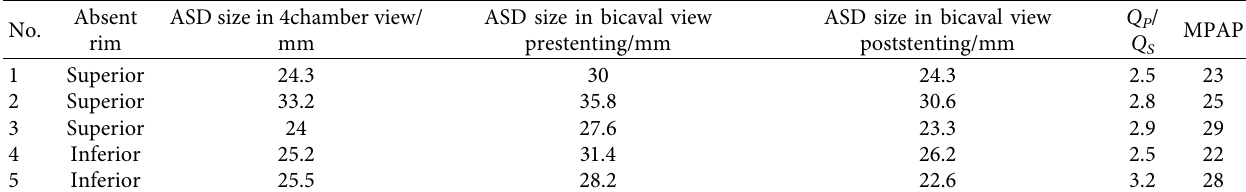
Table 2: Echocardiographic and hemodynamic characteristics of patients.